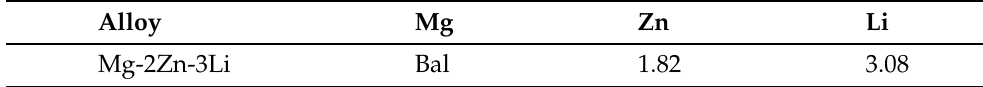
Table 1. The composition of the alloy used in the experiment (wt%).